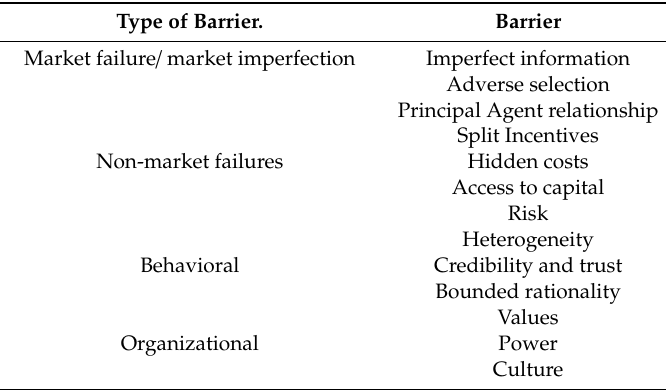
Table 1. Categorization of barriers